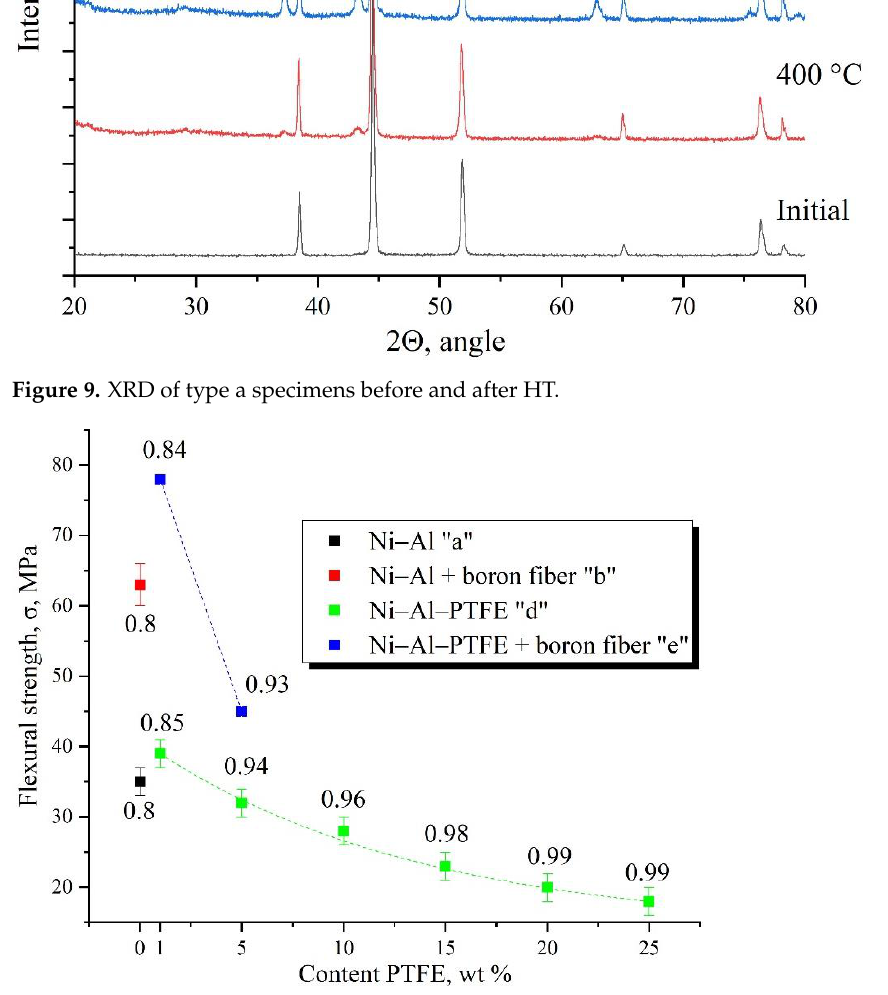
Figure 10. Flexural strength of Ni – Al – PTFE specimens.